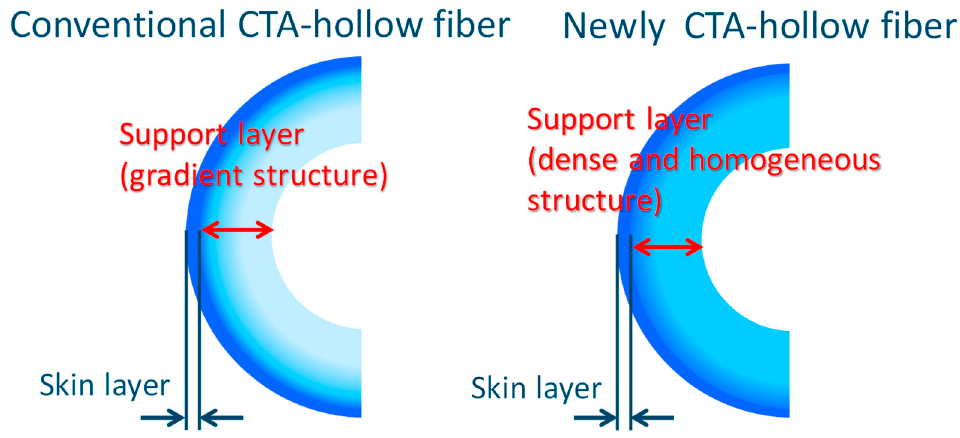
Figure 20. Basic concept of the newly developed CTA-HF membrane.